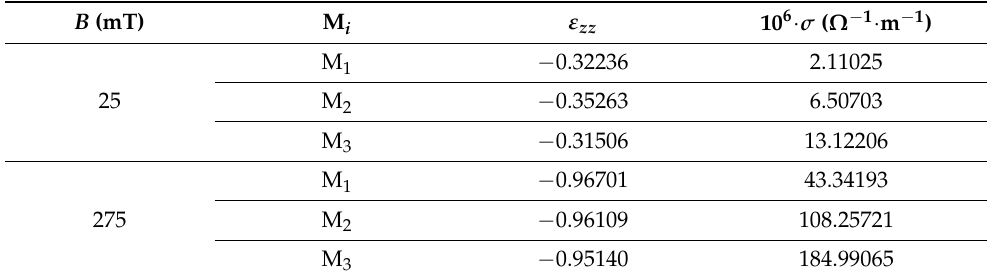
Table 5. The components of deformations, ε zz σ i ( i = 1,2,3 ) , of the membranes M i ( i = 1,2,3 ) for two values of magnetic field. B